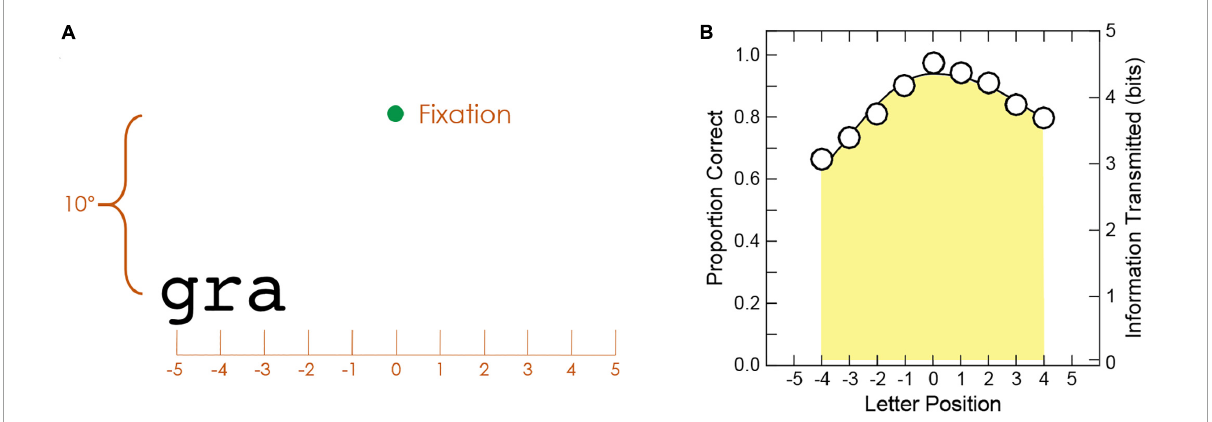
FIGURE2 (A) Illustration of a trigram trial. Only the fixation point and the trigram were shown on the testing screen. The trigram “gra” is centered at position –4. In this case, three letter responses are collected, one for each of the three letter positions (–5, –4, and –3). (B) Sample visual-span profile. The area under the visual-span profile provides the total amount of information transmitted in